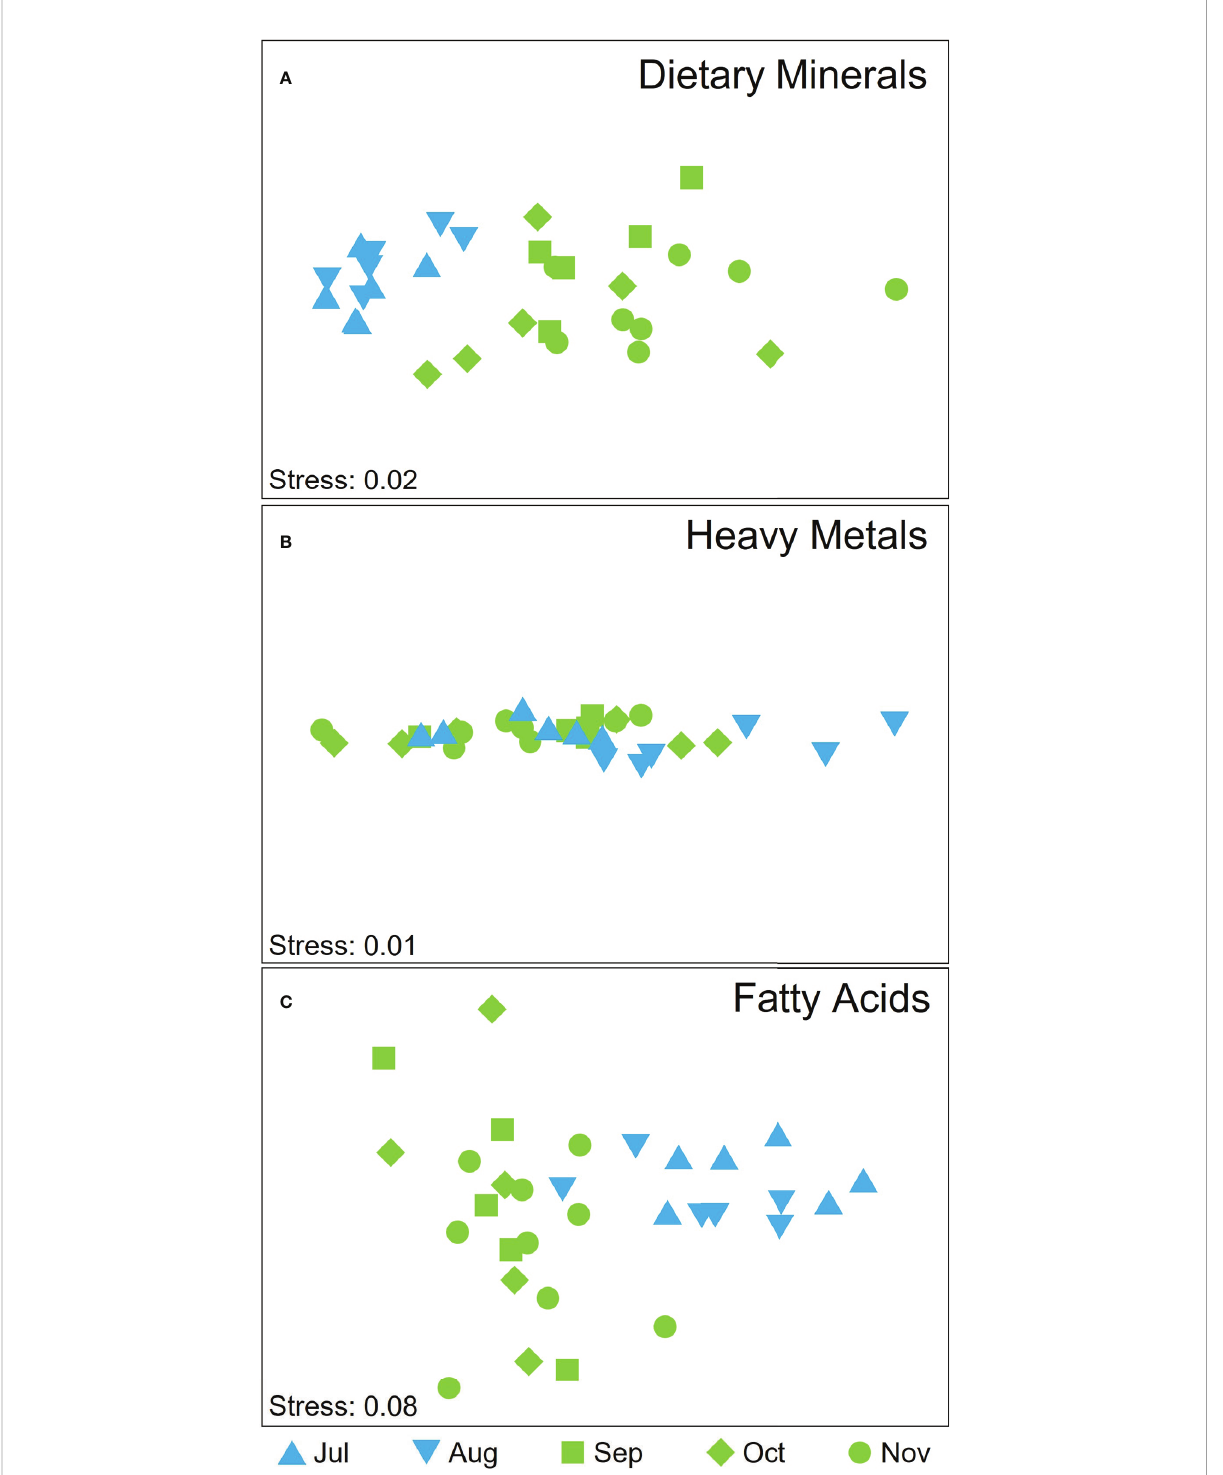
FIGURE 6 nMDS displaying attributes scores for (A) dietary minerals, (B) heavy metal ions, and (C) FA according to harvesting time, where blue symbols depict winter months and green spring months and shapes depict the month of